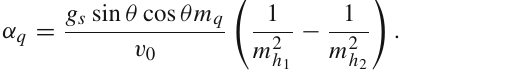
( p , n ) ≡ (cid:3) p , n | m ¯ qq | p,n (cid:4) for q Tq (cid:29) ( p , n ) ( p , n ) = 1 − f . The q = u , d , s Tg Tq